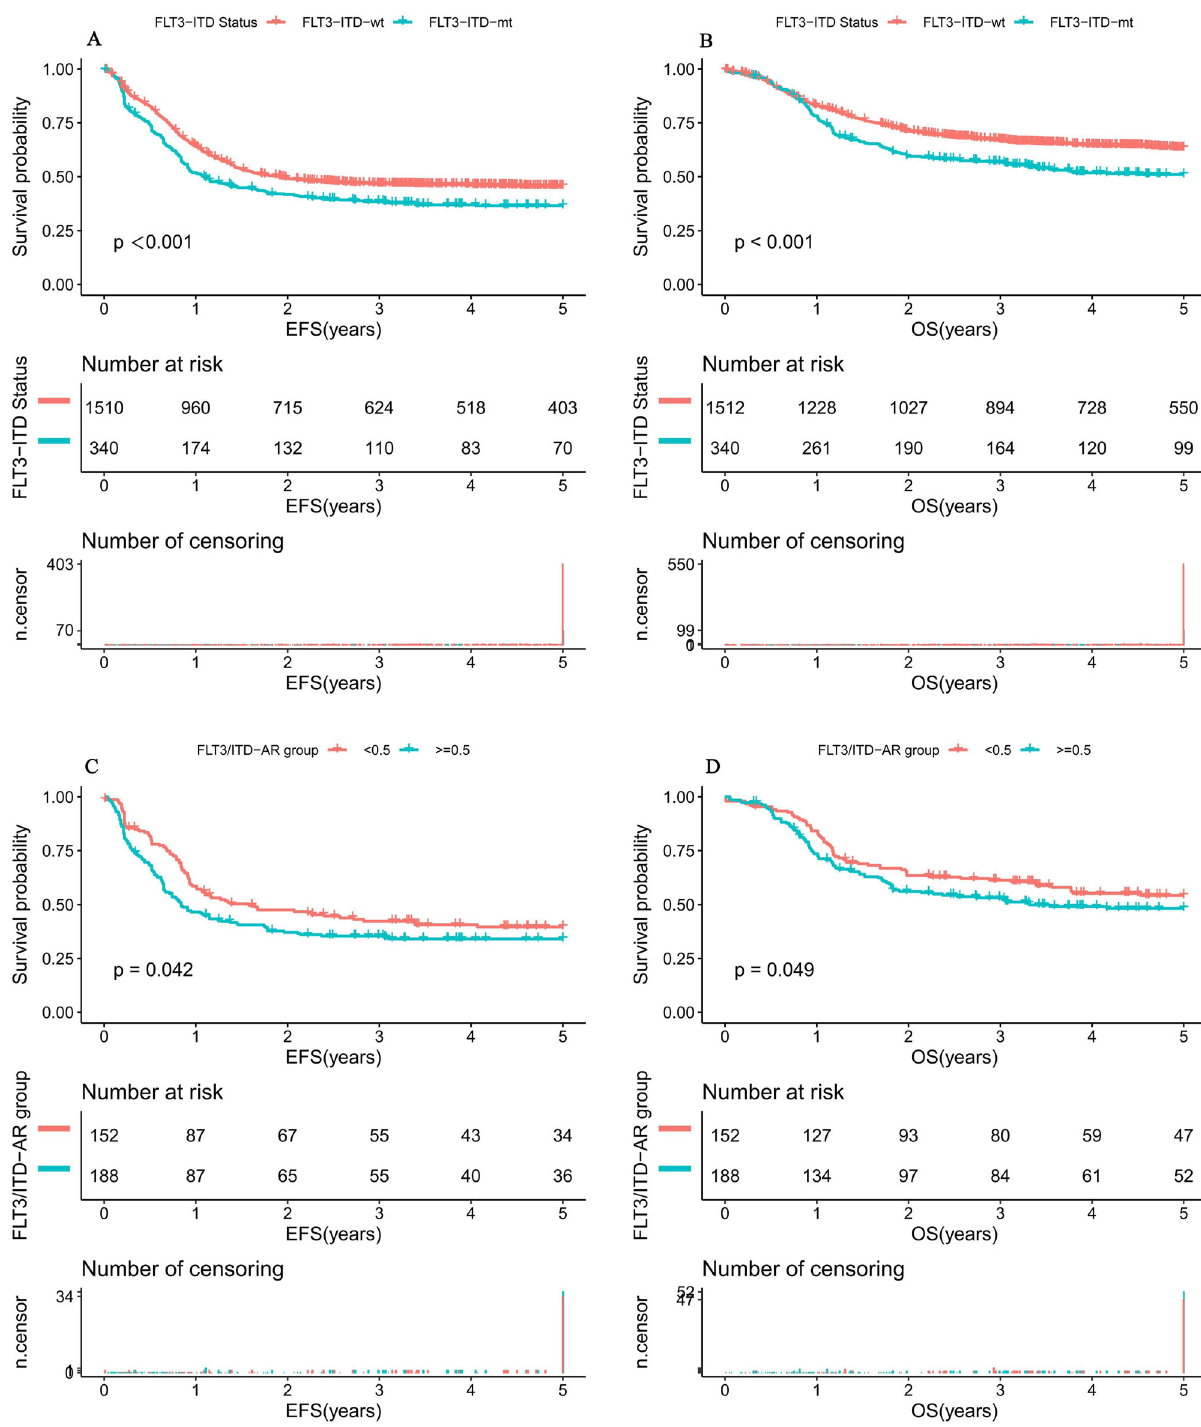
Fig. 1 Survival curves of pediatric AML patients with and without FLT3/ITD mutations and with different AR. A Probability of EFS for all patients with and without FLT3/ITD mutations. B Probability of OS for all patients with and without FLT3/ITD mutations. C Probability of EFS for all patients with different FLT3/ITD AR. D Probability of OS for all patients with different FLT3/ITD AR. Abbreviations: AML acute myeloid leukemia, AR allelic ratio, EFS event-free survival, OS overall survival. EFS and OS were evaluated by the Kaplan – Meier method and compared by log-rank test. Source data are provided as a Source Data fi FLT3/ITD AR ( P < 0.001; Fig. 4A). Similarly, for chemotherapy- only pediatric AML patients, 5-year OS in patients with high AR was also signi fi cantly inferior to those harboring low AR (35.1%